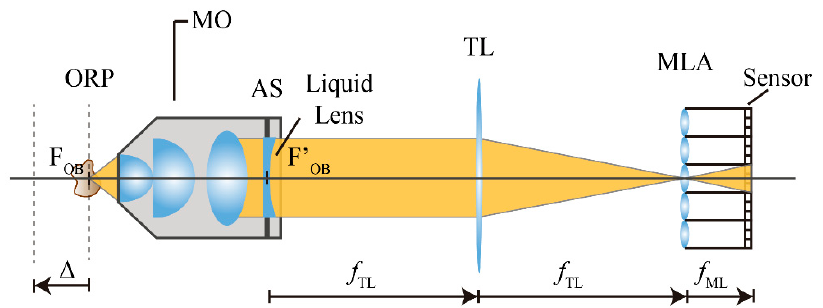
Figure 2. Insertion of a liquid lens at the AS of the MO. With this configuration, a displacement of the object reference plan (ORP) is achieved.